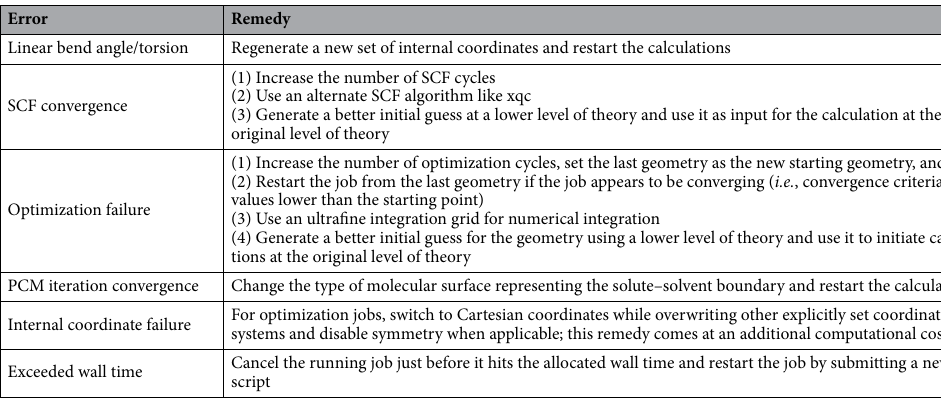
Table 1. Examples of DFT (Gaussian) calculations fixing methods as implemented in